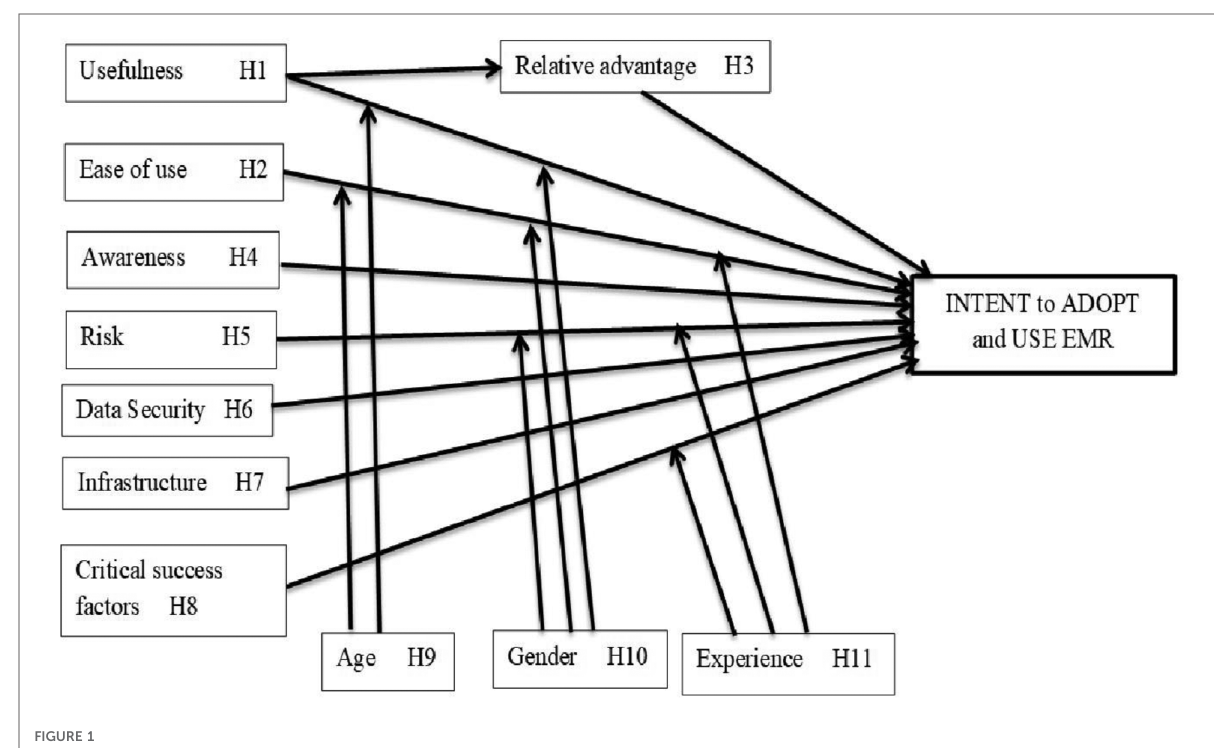
FIGURE 1 EMR adoption